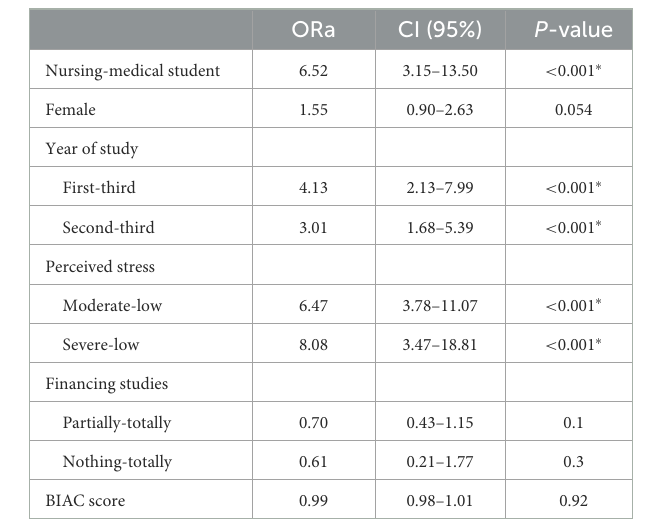
TABLE 3 Binary multivariate logistic regression of factors associated with depression symptoms among medical and nursing students at Ibn Zohr University, Morocco, 2022.